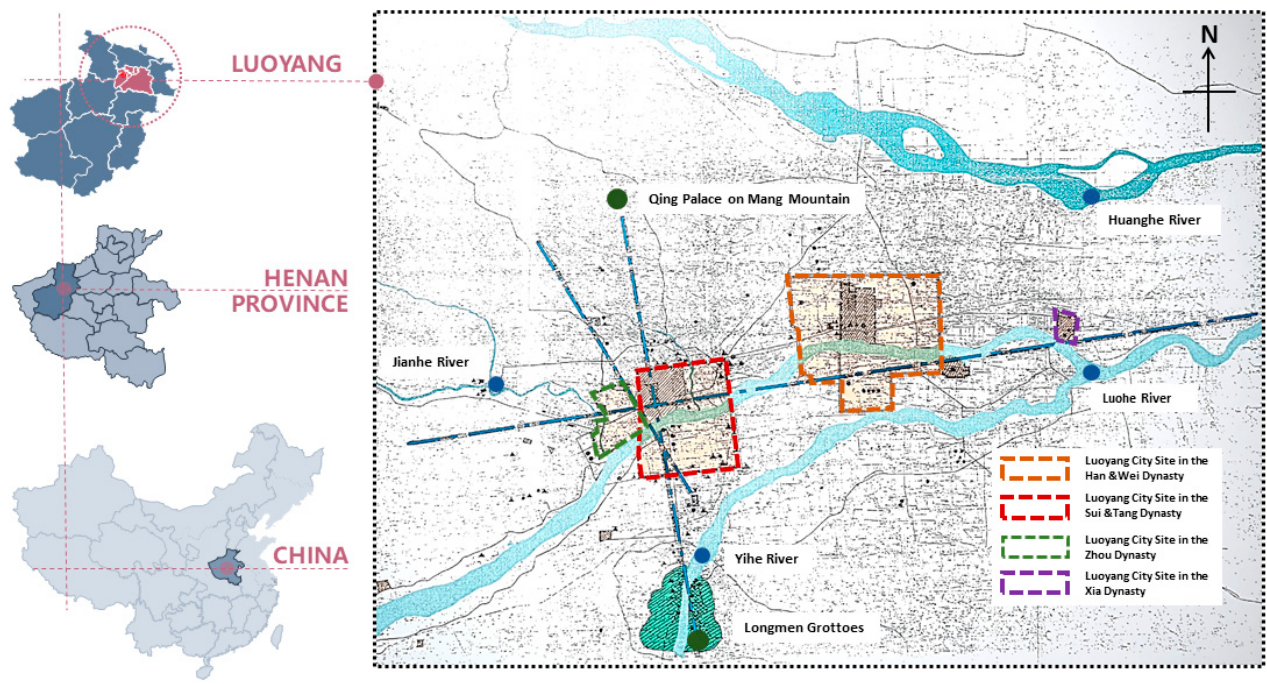
Figure 1. Luoyang capital city site map of the past generations. (Map retrieved from the Luoyang Urban Planning Exhibition Hall.)